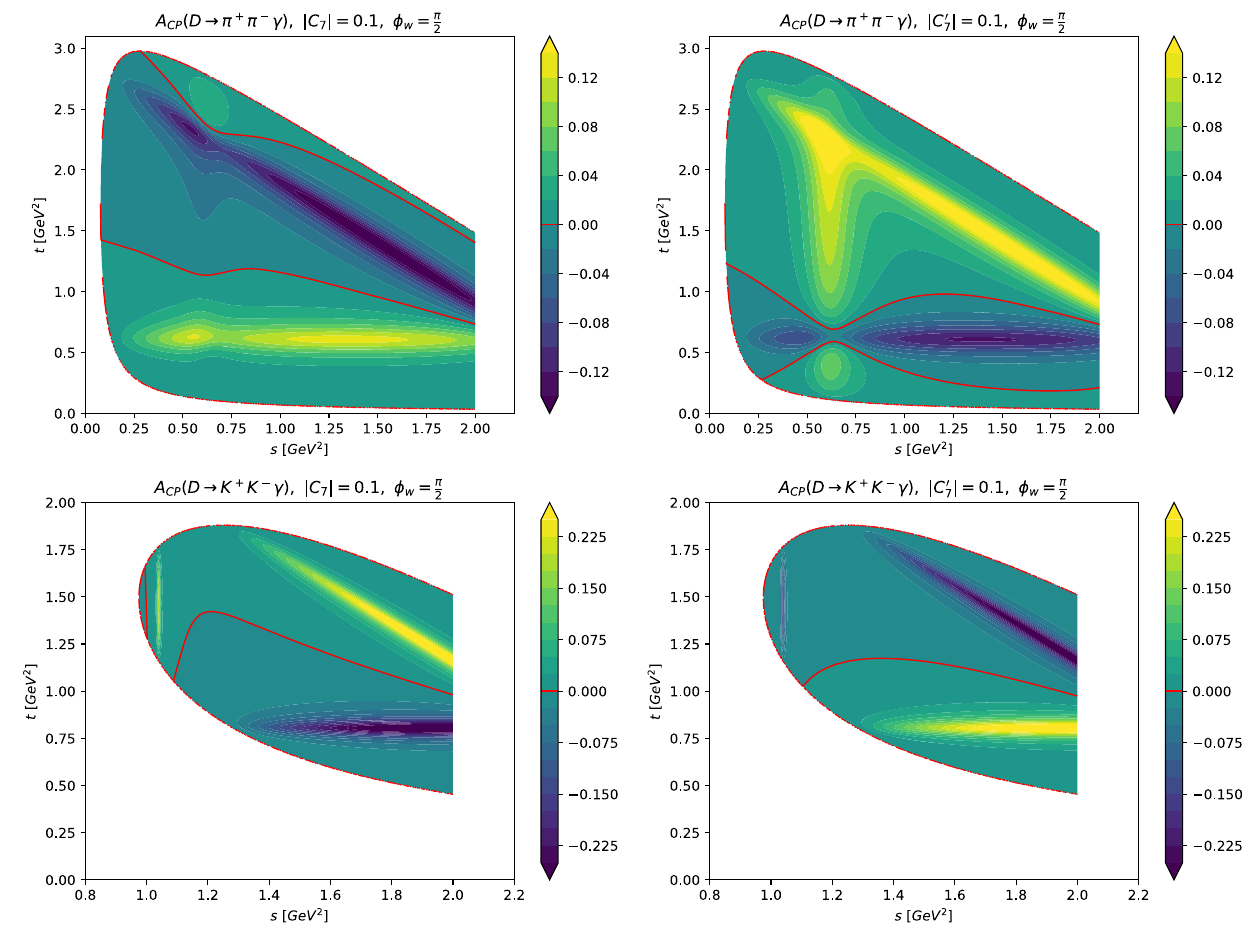
Fig. 13 Dalitz plot of A CP ( s , t ) for D → π + π − γ (upper plots) and weak phase φ w = π/ 2. We employed a cut s ≤ 2GeV 2 to avoid large D → K + K − γ decays (lower plots) based on HH χ PT. We have set one BSM coefficient, C 7 or C (cid:7) , to 0 and the other one to 0 . 1, with 7